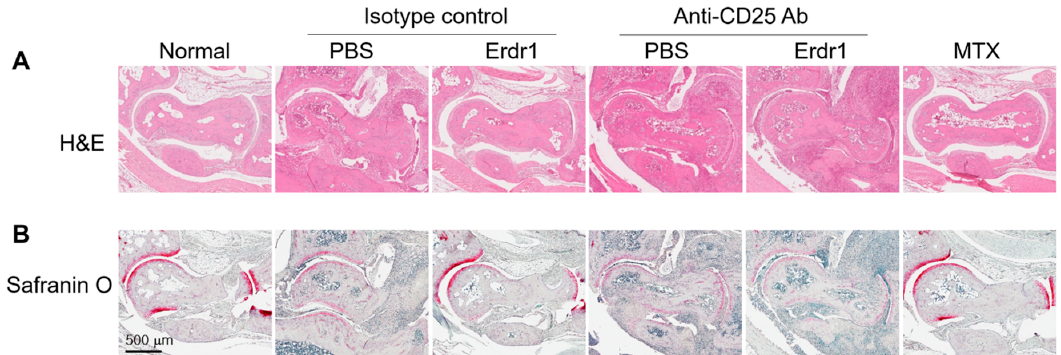
Figure 2. Treg cells involved in the improvement of cartilage damage by Erdr1. Hind-limb tissues from the Treg-depleted CIA experiment were fixed in 4% paraformaldehyde, and paraffin section was performed. After deparaffinization, ( A ) the tissue samples were stained with H&E, and ( B ) cartilages were colored (red) with safranin O (0.2%) at RT. Scale bar = 500 µm.